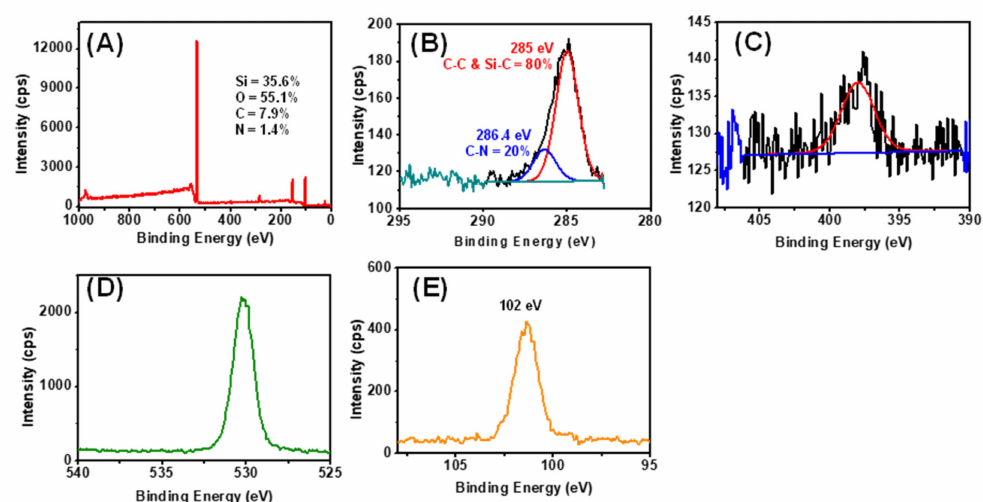
Figure A3. XPS analysis of APDMS on plasma cleaned SiO 2 surface. ( A ) wide, ( B ) C 1s, ( C ) N 1s, ( D ) O 1s, and ( E ) Si 2p spectra.